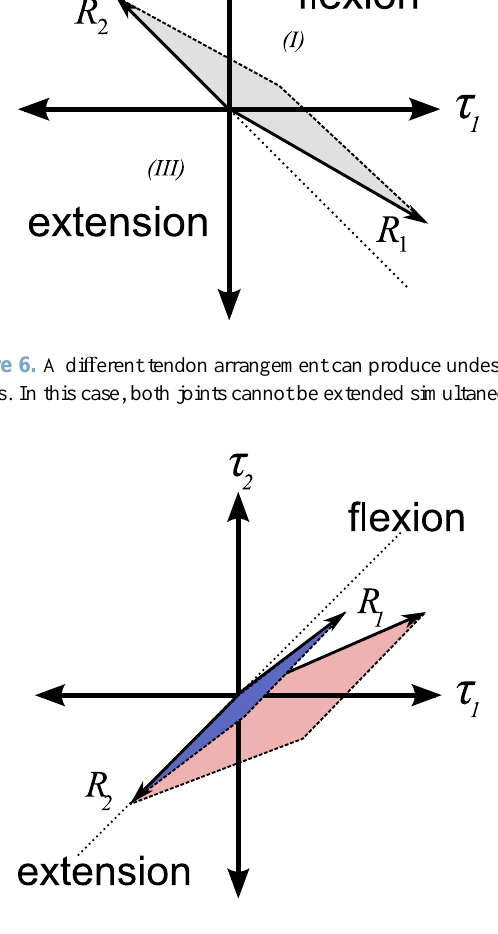
a ff ects the area and r 2